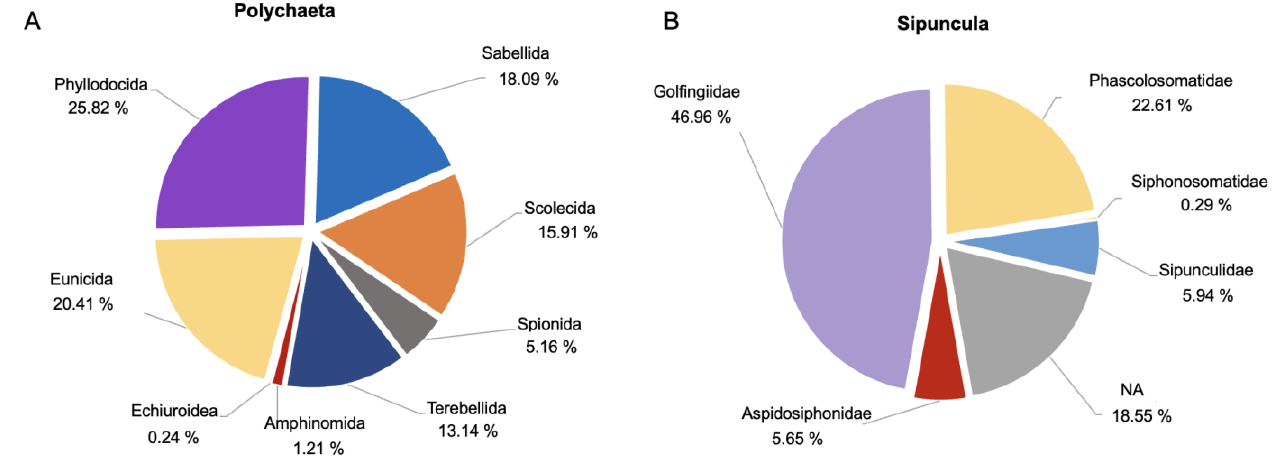
Figure 2. Taxa distribution in the Northwest Pacific within the polychaete ( A ) and sipunculan ( B ) dataset. The pie charts show the composition of polychaete orders, as well as the infraclass Scolecida (31,114 records), and sipunculan families (690 records) occurring within the dataset as a percentage. Records that were not identified beyond the family level are listed under NA.